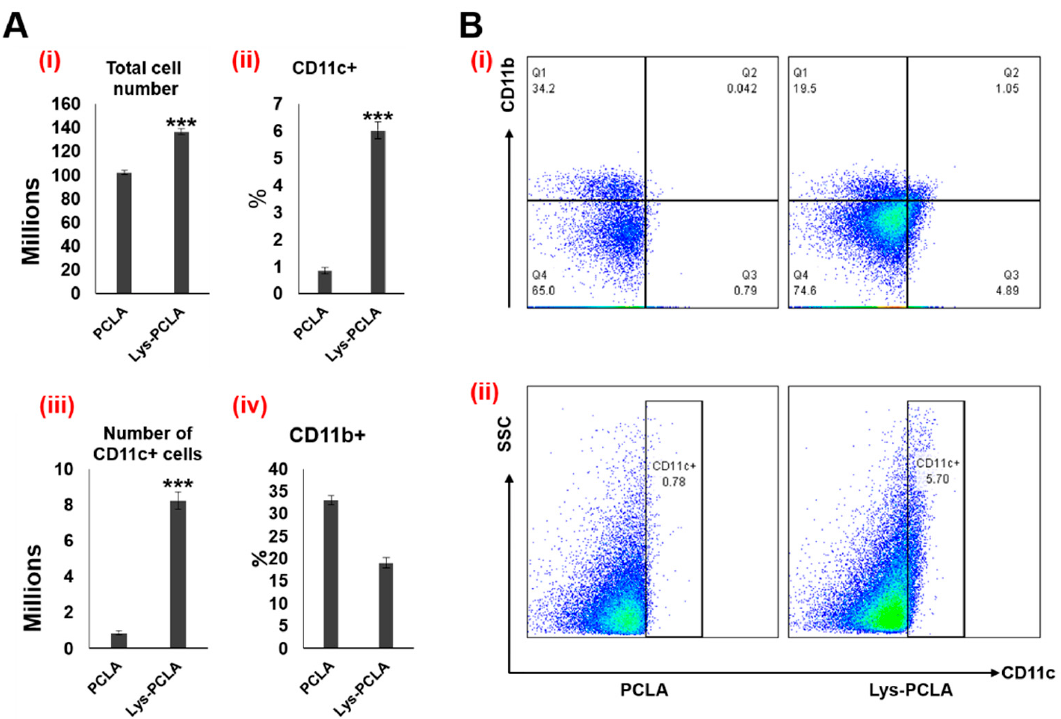
Figure 9. Recruitment of immune cells into the hydrogels. ( A ) ( i ) Total number of host cells recruited by PCLA and Lys-PCLA hydrogels three days after the hydrogel implantation, ( ii ) % of DCs in the total number of cells in ( i ), ( iii ) total number of DCs in ( i ), and % of macrophages collected in ( i ). ( B ) Flow cytometry analysis of CD11b+ macrophages and CD11c+ DCs in PCLA and Lys-PCLA hydrogel three days after injection. *** p < 0.001 versus PCLA hydrogel.